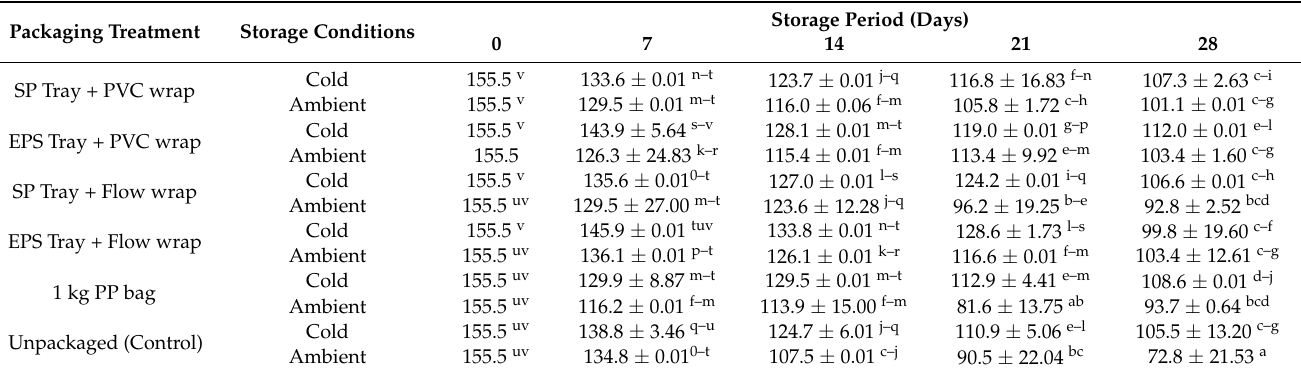
Table 2. Compression (N) test of tomatoes influenced by the packaging and storage conditions over a 28-day storage period ( n =